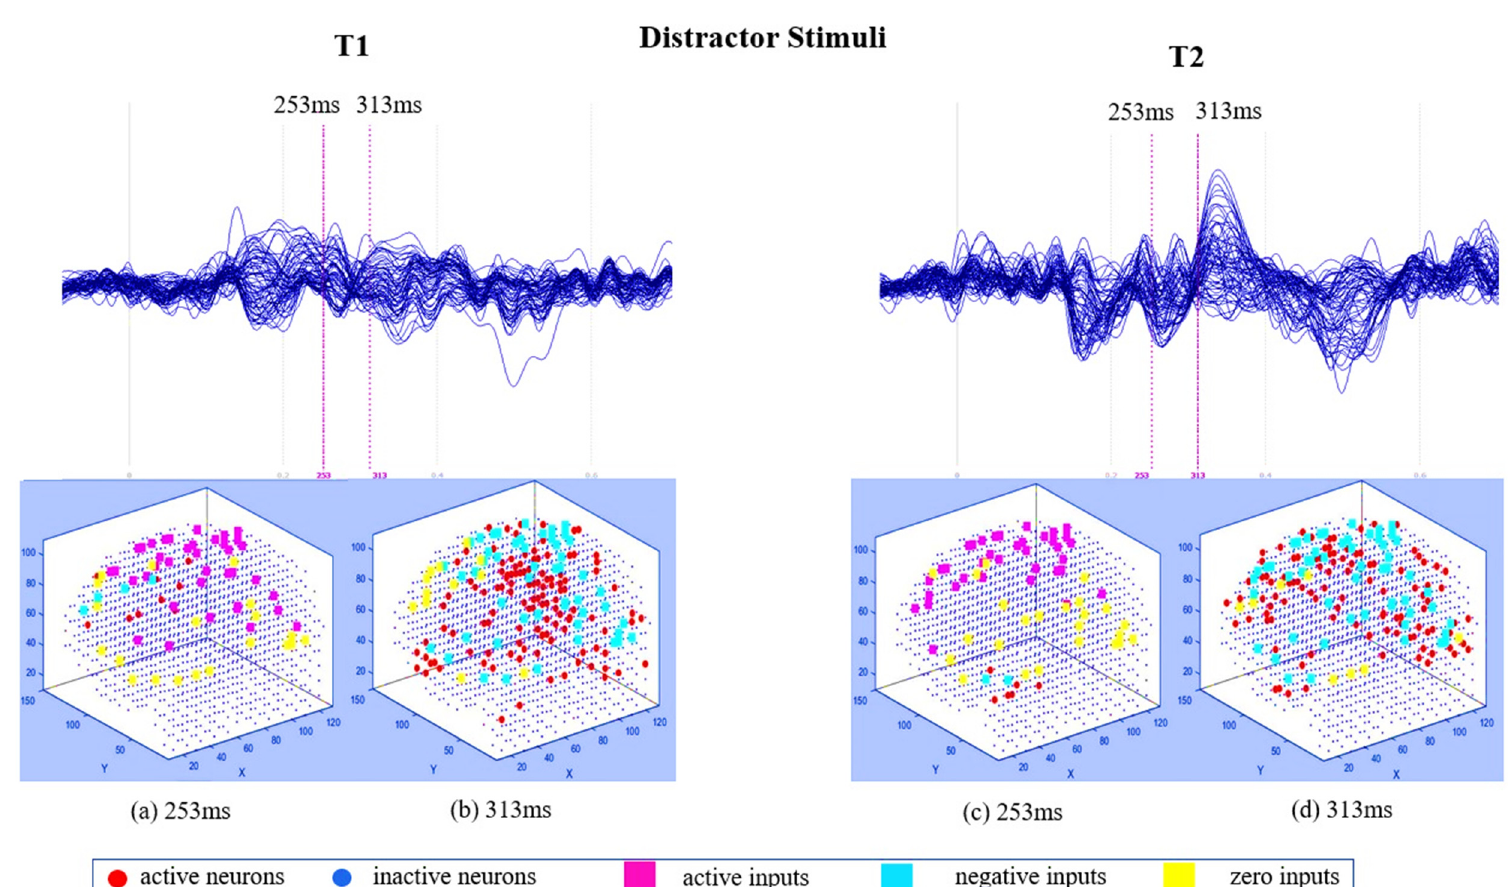
Figure 3. The averaged ERP waveforms across 62 EEG channels before (T1) and after (T2) the mindfulness training in response to distractor stimuli for an experimental participant. ( a , c ) Comparison of clusters of active inputs (positive spiking activity) in the SNN model corresponding to ERP latency of 253 ms post-stimulus at T1 and T2; ( b , d ) comparison of clusters of negative inputs (negative spiking activity and the neuron firings) in the SNN model corresponding to ERP latency of 313 ms post-stimulus at T1 and T2.